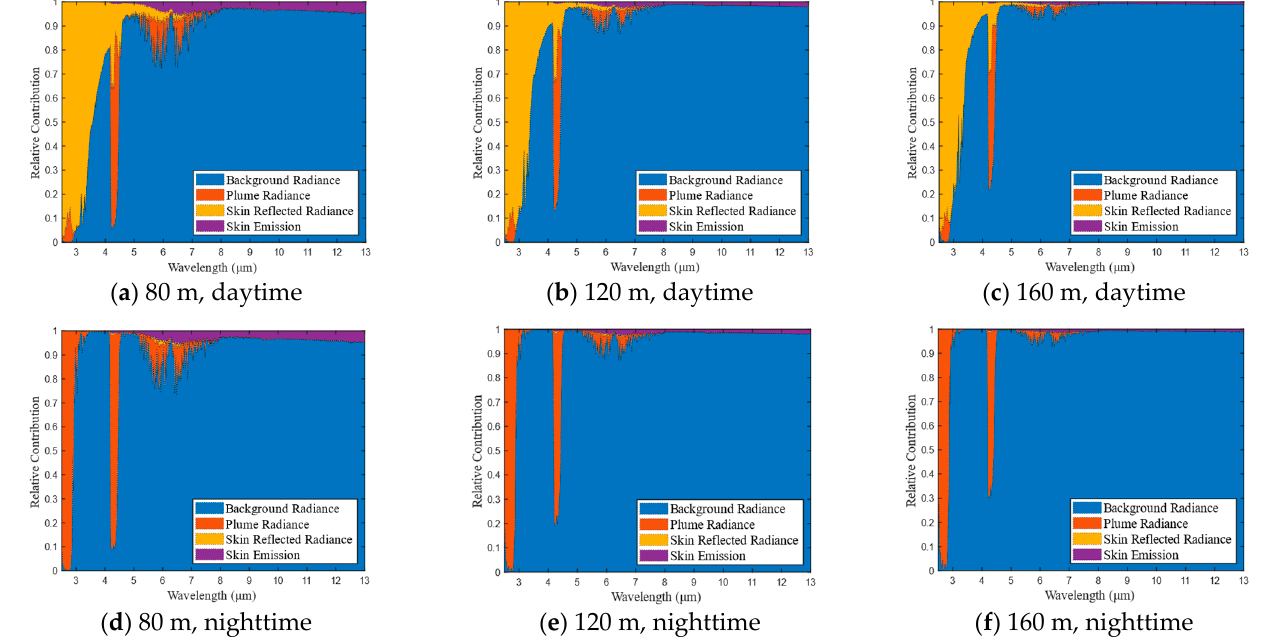
Figure 7. Relative contributions for the body-leaving radiance at 2.5–13 µ m. ( a – c ) are the contribution plots of three spatial resolutions in the daytime; ( d – f ) are the contribution plots in the nighttime; the blue, red, yellow, and purple areas represent the relative contribution of the background radiance, plume radiance, skin reflected radiance and skin emission radiance,